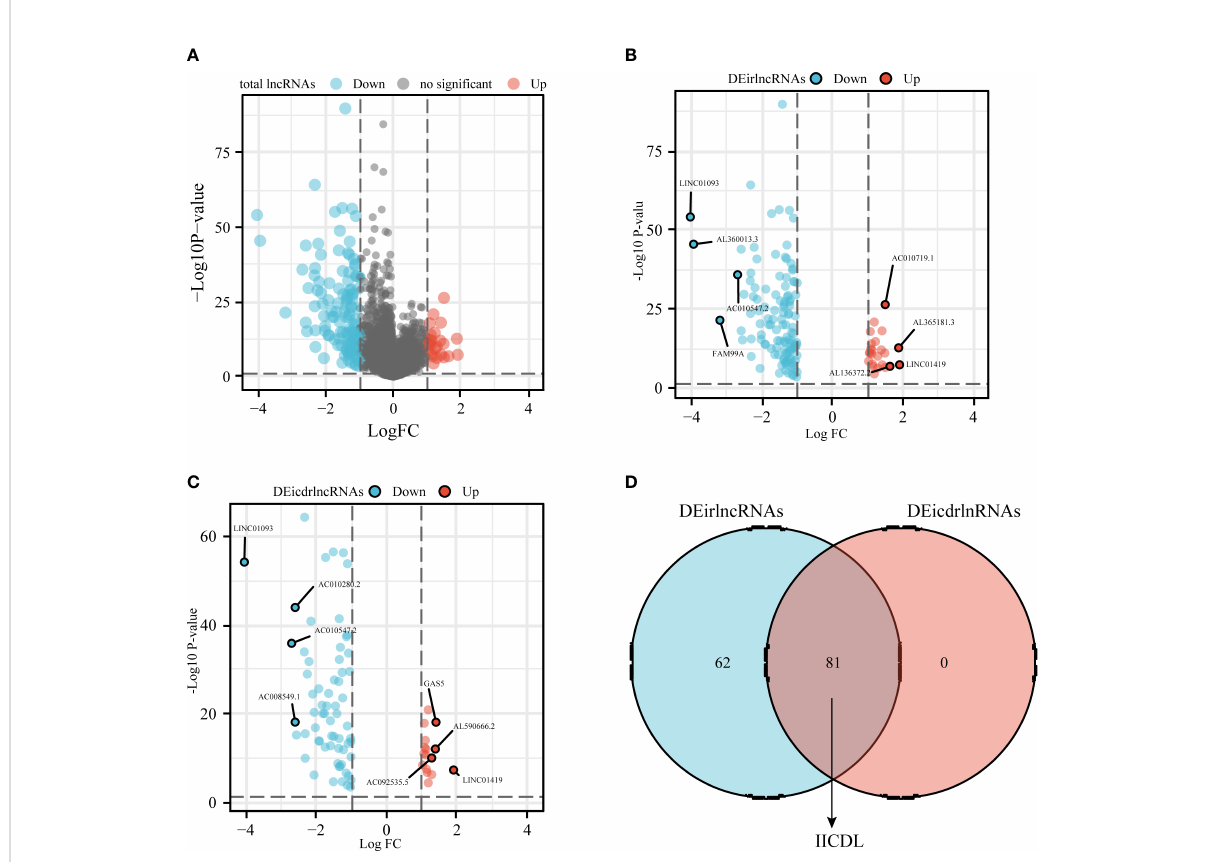
FIGURE 2 Identi fi cation of differentially expressed IICDLs in TCGA (A) Identi fi cation of differentially expressed lncRNAs in TCGA-HCC cohort. Volcano diagram showing DEirlncRNAs (B) and DEicdrlncRNAs (C) . (D) Intersection of the two sets of differentially expressed lncRNAs. DEirlncRNAs: differentially expressed immune-related lncRNAs; DEicdrlncRNAs, differentially expressed immunogenic cell death-related lncRNAs; IICDLs, immune-related and immunogenic cell death-related lncRNAs; TCGA, The Cancer Genome